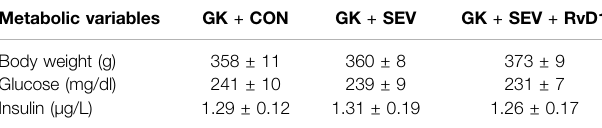
TABLE 2 | Metabolic parameters in GK rats. Metabolic variables